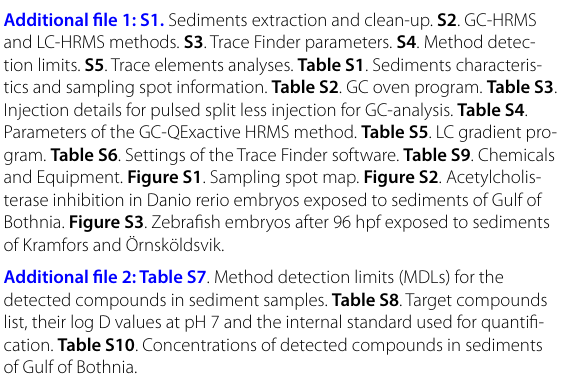
gram. Table S6 . Settings of the Trace Finder software. Table S9 . Chemicals and Equipment. Figure S1 . Sampling spot map. Figure S2 . Acetylcholis- terase inhibition in Danio rerio embryos exposed to sediments of Gulf of Bothnia. Figure S3 . Zebrafish embryos after 96 hpf exposed to sediments of Kramfors and Örnsköldsvik.